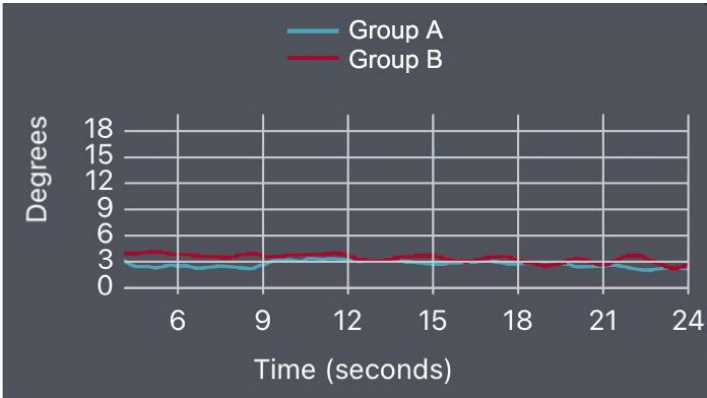
Figure 9. PBT flexion – extension diagram for Groups A and B.